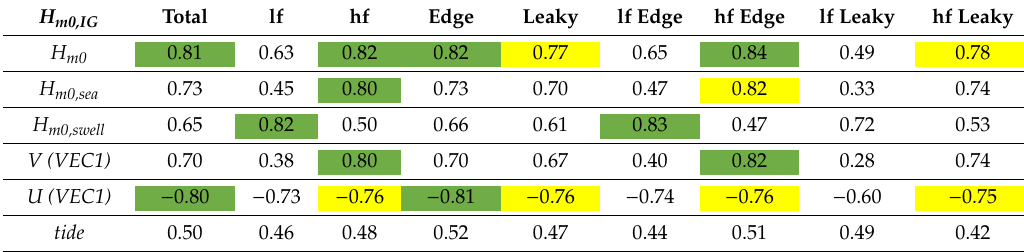
Figure 9. Ratio of low-frequency to high-frequency edge wave height versus ratio of swell to wind-sea wave height. Table 1. Correlation coe ffi cients, R, between di ff erent components of IG wave height (total, low frequency (lf), high frequency (hf), edge waves only, leaky waves only, low-frequency edge waves, high-frequency edge waves, low-frequency leaky waves and high-frequency leaky waves) with wave height (total, wind-sea, swell and ratio swell to wind-sea), current velocity and tidal elevation, based on three hourly observations. Note the current velocities represent cross-shore average values. High correlation coe ffi cients are highlighted: green background indicates values ≥ 0.80 and yellow background indicates values between 0.75 and 0.80. In addition, the highest (absolute) coe ffi cients in each column are